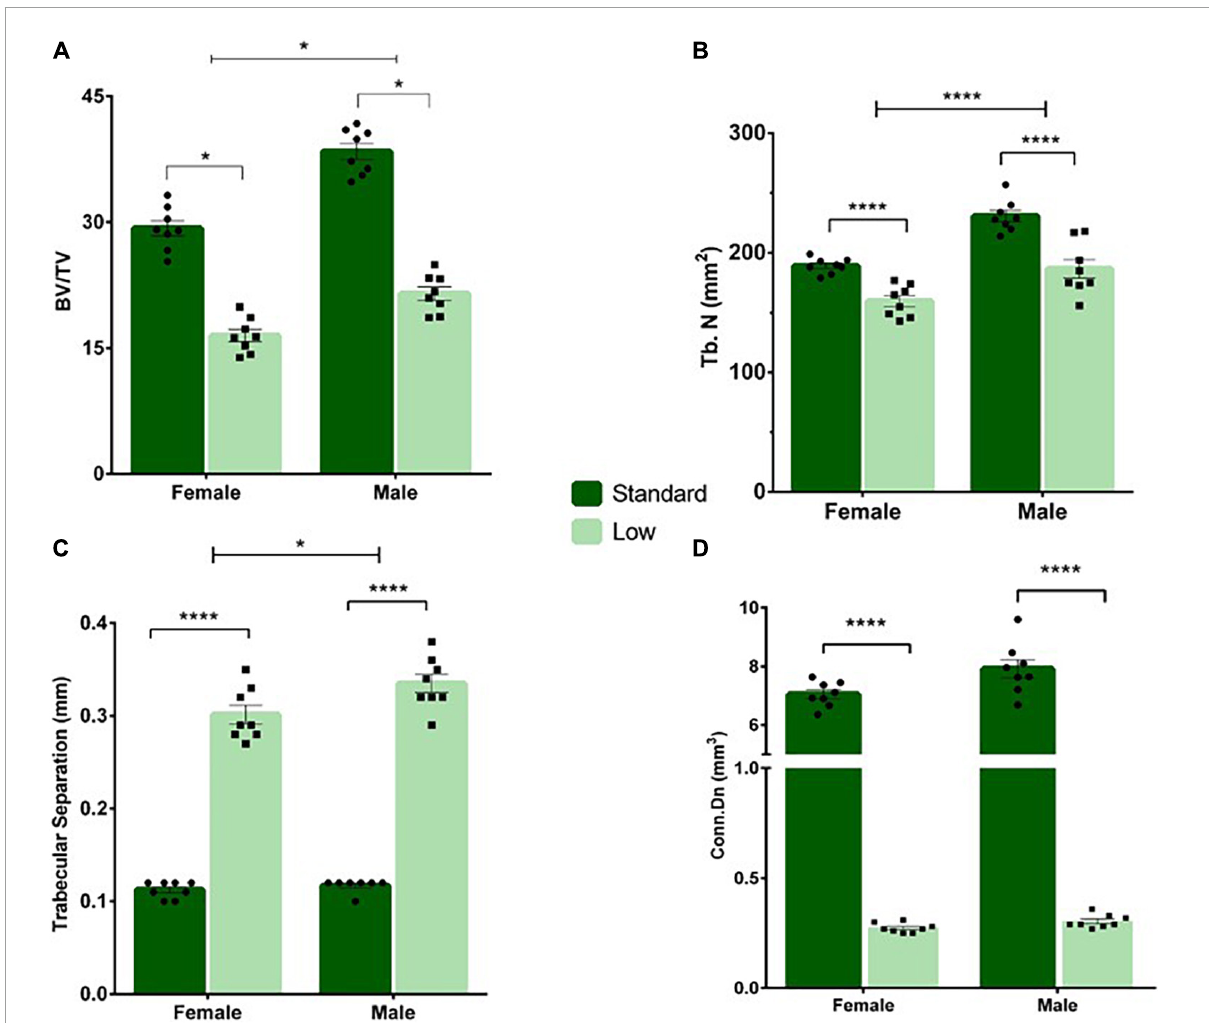
FIGURE10 Tail vertebrae characterization and measurements. A variety of morphometric analyses were performed on the tail vertebrae in standard and low resource rats including (A) bone volume fraction, (B) trabecular number, (C) trabecular separation, and (D) connectivity density. (A) Following two-way ANOVA, a significant sex by resource interaction was found (* p = 0.021) where males had higher bone volume fraction compared to females, and standard rats had a higher bone volume fraction compared to low resource rats. (B) A significant main effect of sex was observed for the trabecular number, where the number of trabecula in a given area was greater in males, and in SR rats (**** p < 0.001). (C) A significant effect of resources was found for trabecular separation (i.e., the distance between trabecula), where LR rats had greater trabecular separation compared to SR rats (**** p < 0.001). (D) A significant interaction of sex by resources was present for connectivity density, where standard males exhibited higher connectivity density than standard females, and all standard rats had greater connectivity density compared to low resource rats (**** p < 0.001). Individual data points overlay bars showing means ± SEM. For (A–D) : n = 8 for SR females, SR males, and LR females; n = 6 for LR